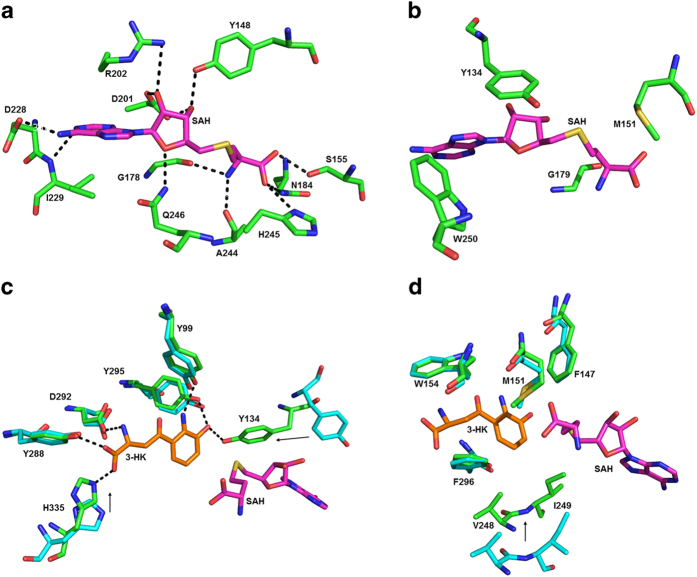
Ligand interactions in the active site. In (a) the SAH-interacting residues via hydrogen bonds are shown as stick models. The nitrogen, oxygen, and carbon atoms are colored blue, red, and green. The bound SAH is shown with magenta carbons. Black dashes represents the potential hydrogen bonds. The remaining SAH-interacting residues are shown in (b). The 3HK-interacting residues via hydrogen bonds are shown in (c) and the remaining residues in (d). For comparison, the residues from the unbound structure are also shown in (c) and (d), with cyan carbons.